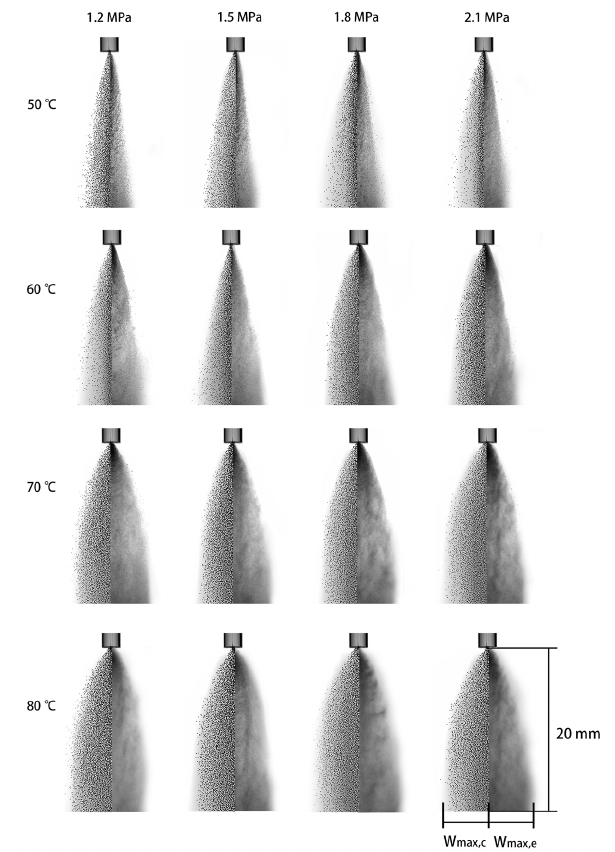
Figure 4. Experimental and numerical results of spray patterns with different injection pressures and temperatures (The left parts of spray images are simulation results; the right parts of spray images are experimental results).